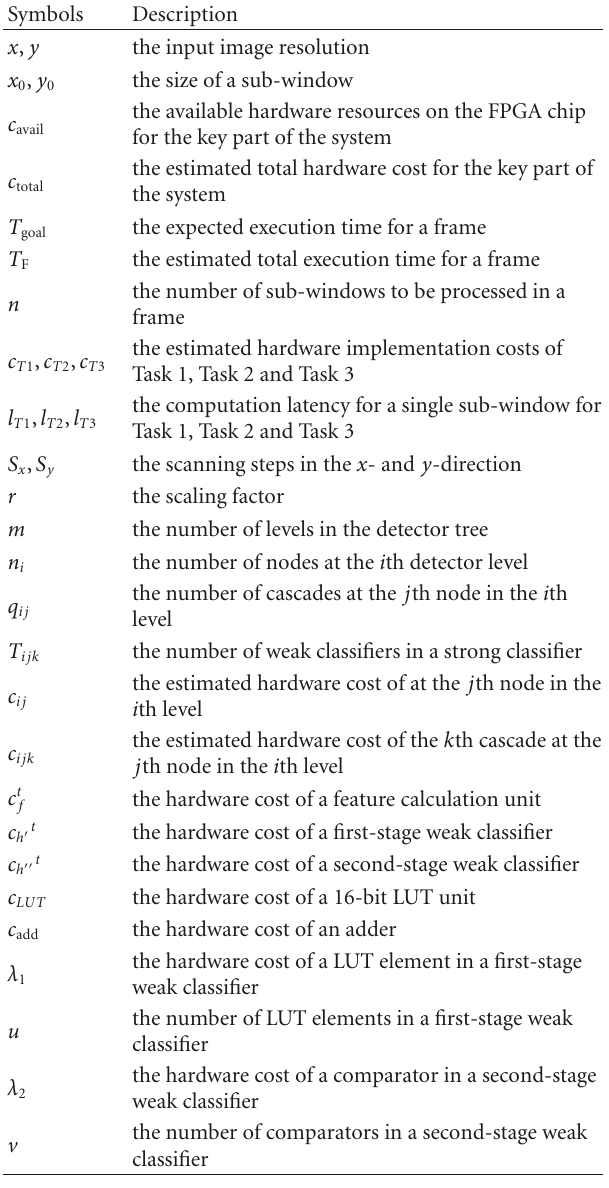
Table 1: List of related